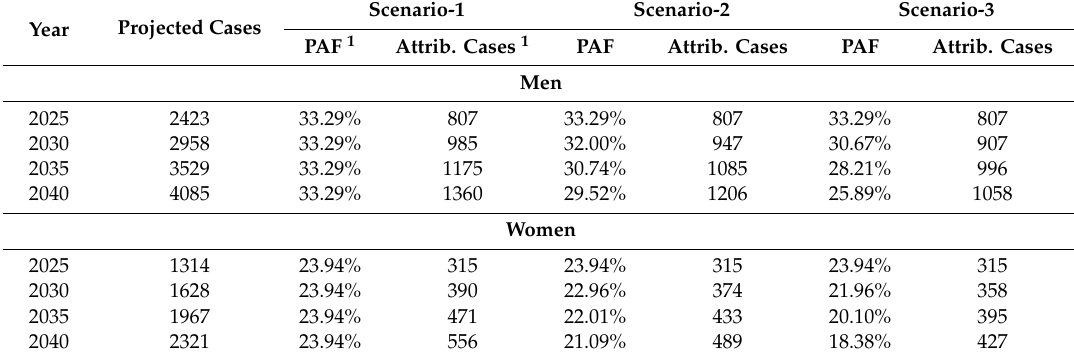
Table 3. Projections of combined population attributable fractions and attributable CRC cases under di ff erent scenarios, 2025–2040.